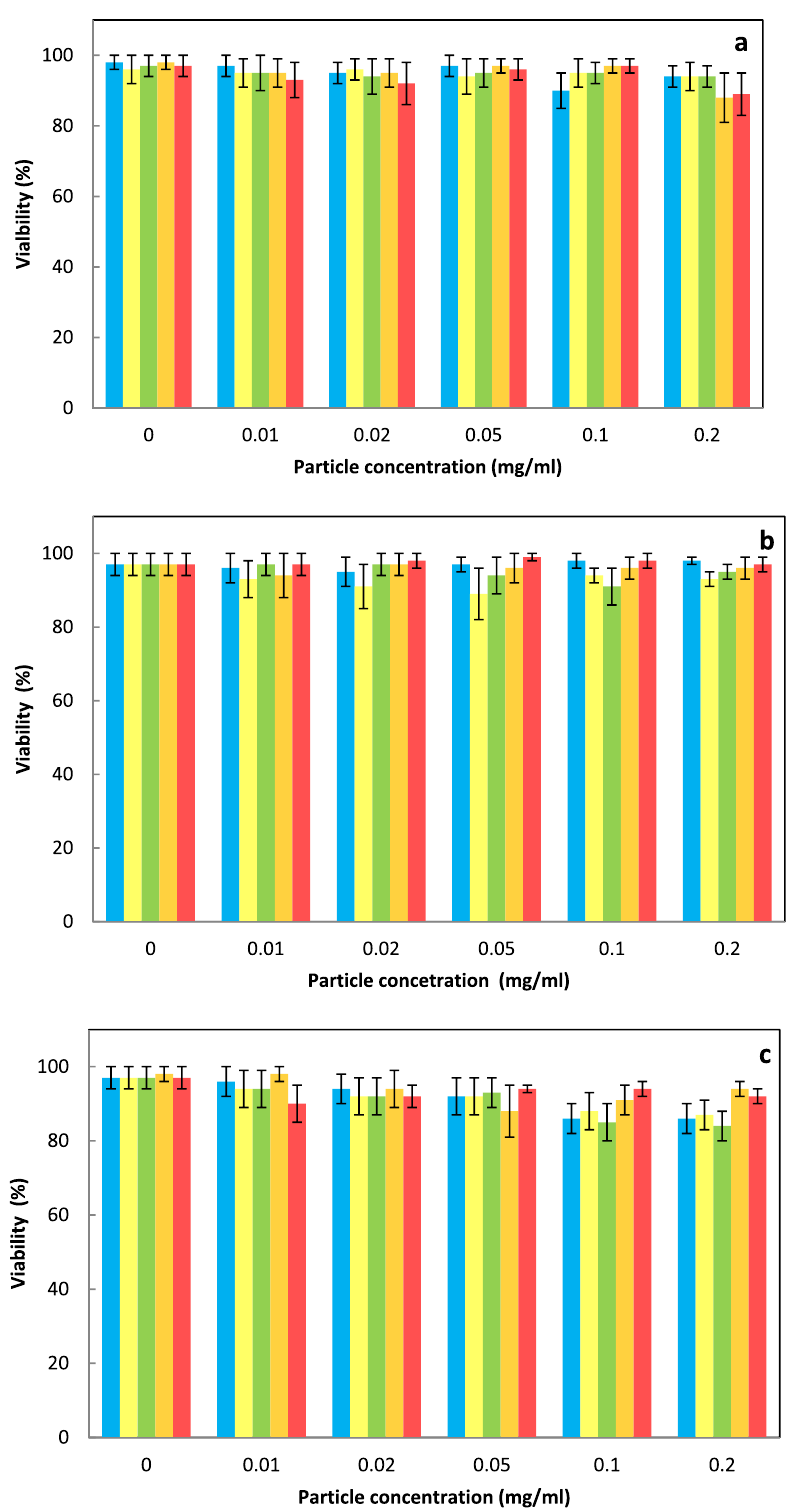
Figure 6. Viability of ( a ) HeLa, ( b ) HepG2, and ( c ) INS-1E cells incubated with CS-UCNP (blue), CS-UCNP@ Ner-PEG (yellow), CS-UCNP@Ale-P(DMA-AEC)-DY-615 (green), CS-UCNP@Ale-PDMA-DY-615 (orange), and CS-UCNP@Ale-P(DMA-AMPS)-DY-615 (red) for 24